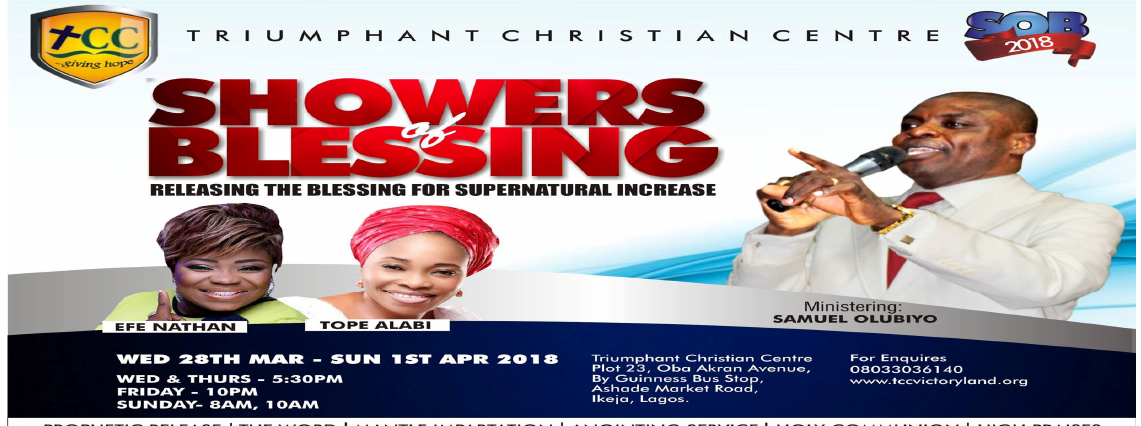
Figure 4. This is another poster promoting and inviting people to a church event. On the poster is the picture of the host Pastor, Samuel Olubiyo, and the two superstar guest gospel musicians/min ‐ isters/artists, Efe Nathan and Tope Alabi. (Image: courtesy of the Triumphant Christian Centre, Ikeja, Lagos, accessed on 15 January 2022).